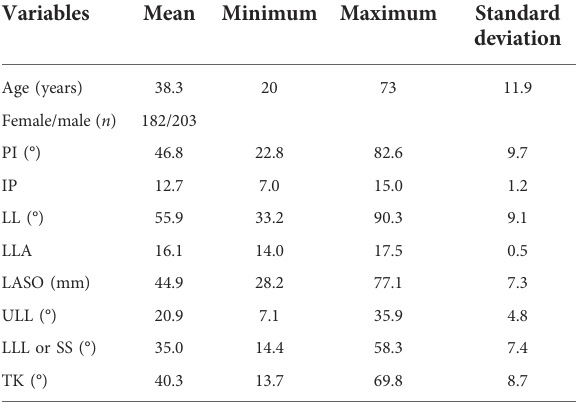
TABLE 3 The PI strati fi ed IP in asymptomatic Chinese adults with different gender groups.